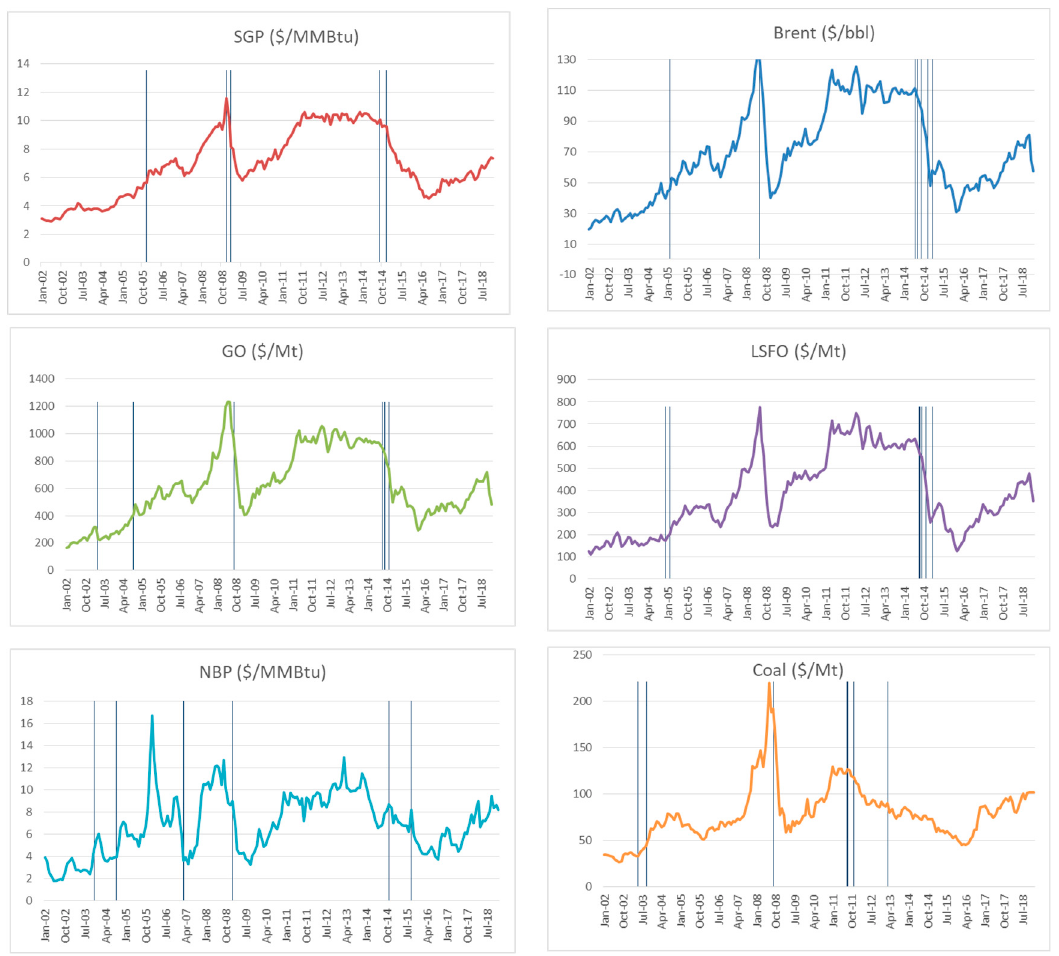
Figure 4. Break dates crash model.